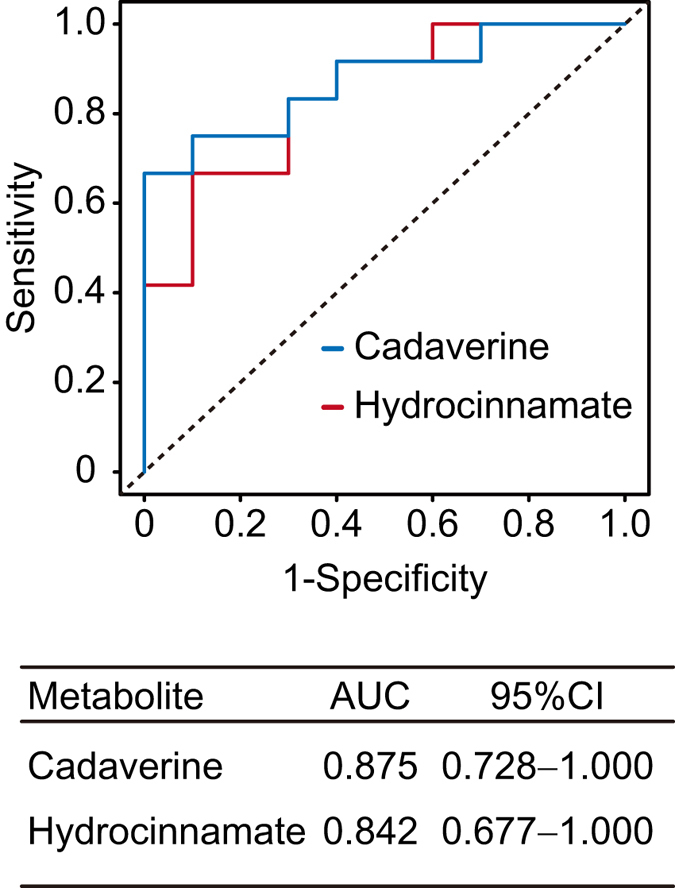
Receiver operating characteristic (ROC) curves for cadaverine and hydrocinnamate used to identify severe periodontitis.The area under the curve (AUC), as well as ROC curves for cadaverine and hydrocinnamate used to identify severe periodontitis are presented.